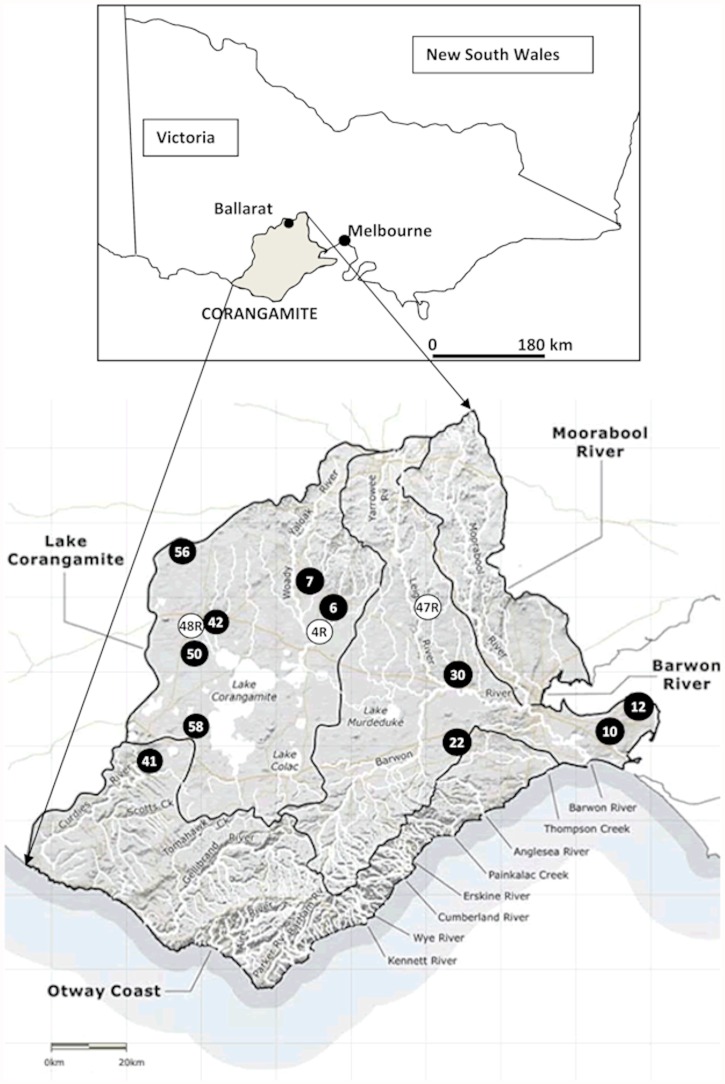
Location of Allocasuarina verticillata populations from the Corangamite Catchment (shaded in grey) in southeastern Australia.Numbers correspond to populations in Table 1; white circles indicate restored sites.